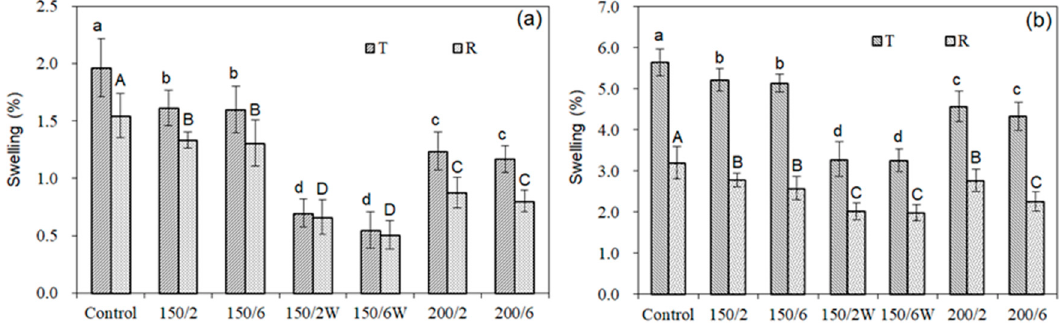
Figure 2. Water adsorption swelling ( a ) and water absorption swelling ( b ) of the control and modified groups in the tangential and radial direction. Bars showing different letters demonstrate significant difference ( p < 0.05) according to Duncan’s multiple range tests.